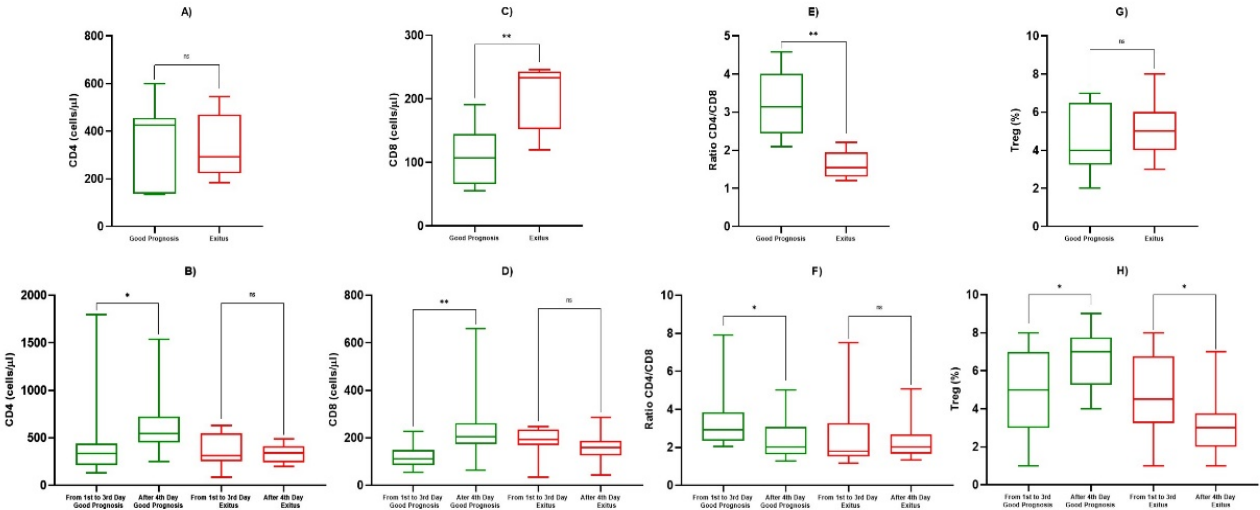
Figure 4. Box and whiskers for lymphocyte subpopulations in the Good Prognosis Group and the Exitus Group. In ( A ), CD4+ T-lymphocytes at the first observation; in ( B ), CD4+ T-lymphocytes for the determinations made between the first and third day and from the fourth day onwards; in ( C ), CD8+ T-lymphocytes at the first observation; in ( D ), CD8+ T-lymphocytes for the determinations made between the first and third day and from the fourth day onwards; in ( E ), CD4+/CD8+ lymphocytes ratio at the first observation; in ( F ), CD4+/CD8+ lymphocytes ratio for the determinations made between the first and third day and from fourth day onwards; in ( G ), % of Tregs at the first observation; in ( H ), % of Tregs for determinations made between the first and third day and from the fourth day onwards. The significant p -values are marked with *(from 0.01 to 0.05) or ** (from 0.001 to 0.01), not significant are marked with ns ( ≥ 0.05).